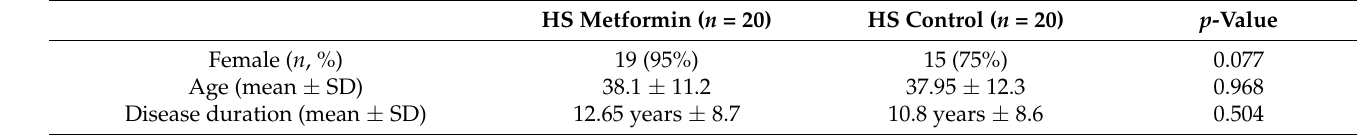
Table 1. Demographics, metabolic parameters, CRP, and CV risk biomarkers for HS metformin and HS controls